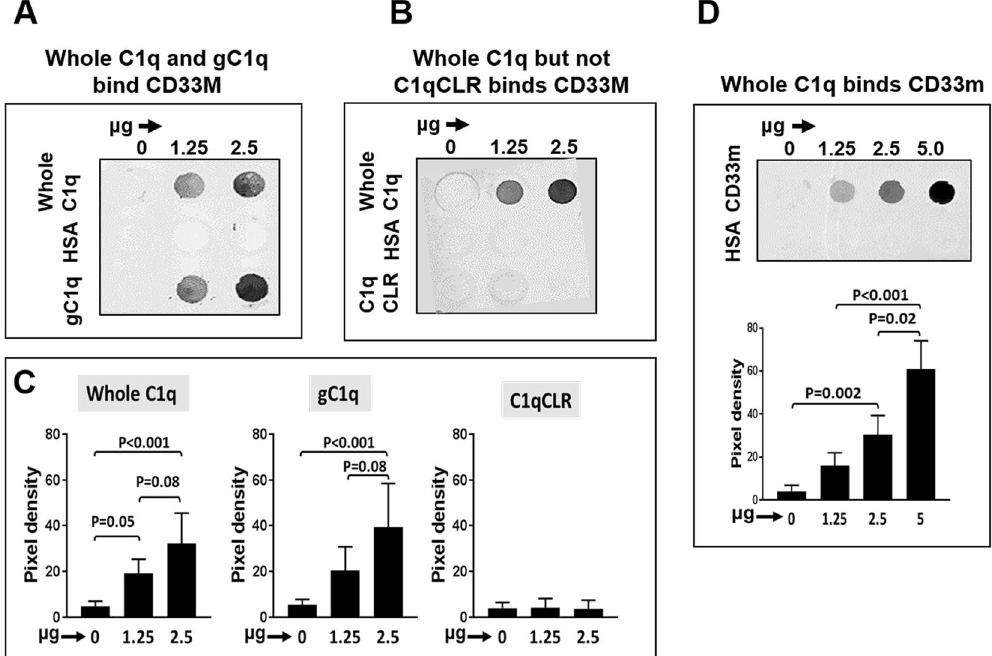
Figure 1. Evidence for domain-specific and concentration dependent associations between C1q and CD33 using purified proteins in slot blot assays. Unlabeled proteins were immobilized on membranes; biotin labeled proteins were in solution. ( A–C ) Dose related binding of immobilized whole C1q and gC1q, but not CLR, to biotin-CD33M (5 ug/ml). ( D ) Biotin-whole C1q (10 ug/ml) binds to immobilized CD33m (lacking the extracellular V-like domain and expressing the C2-like domain) in a dose specific manner. (HSA = human serum albumin control showing no reactivity. Bound proteins were detected using streptavidin conjugated Infrared 800 (LI-COR). Pixel density was determined by densitometry. (C , D) Bar graphs represent the mean ± SE of pooled data; one-way ANOVA followed by Tukey’s pairwise multiple comparison was used to determine significance. N ≥